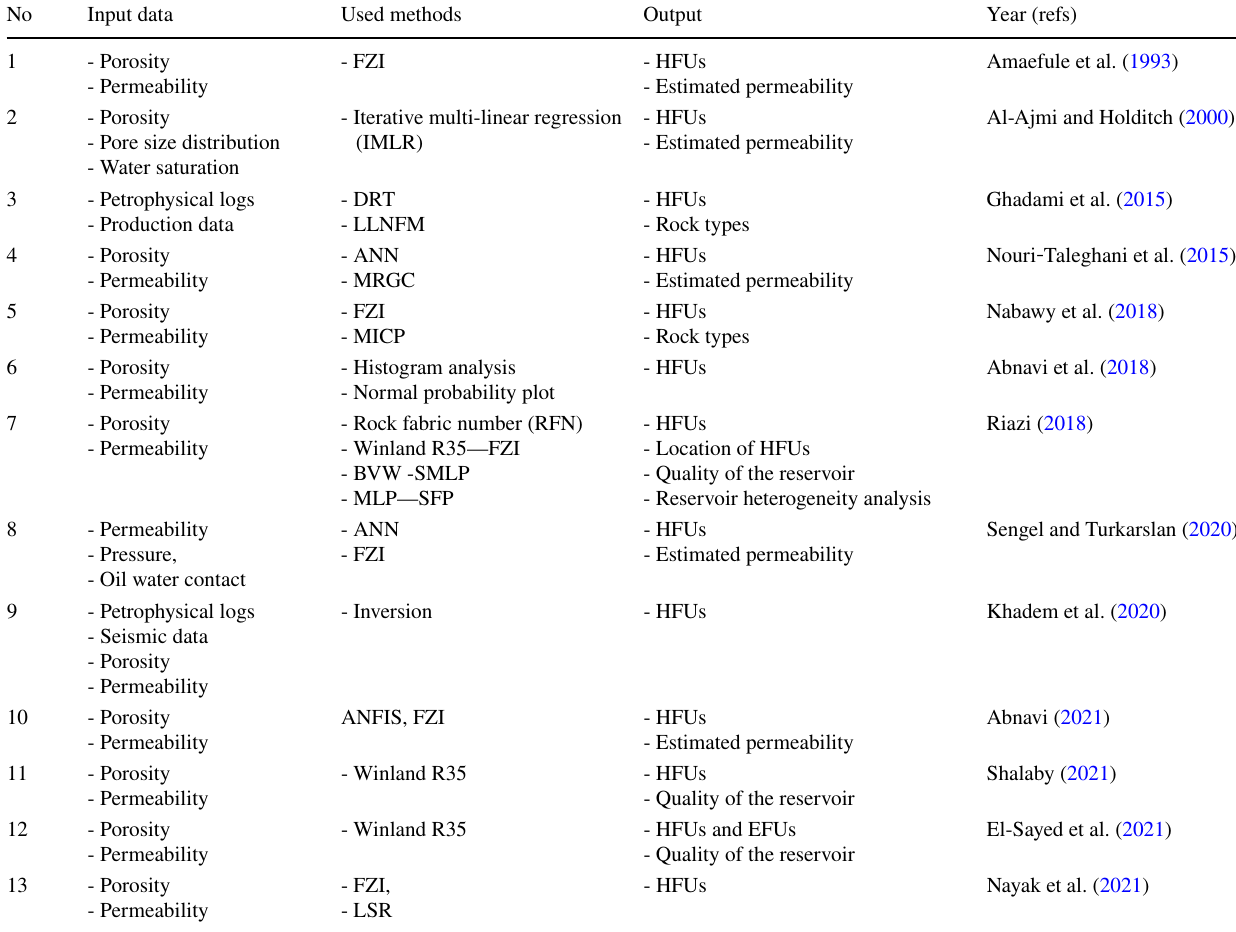
Table 1 Summary of some of related articles studied in HFU